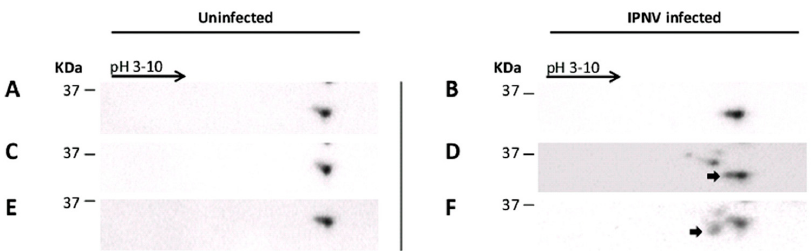
Figure 4. Effect of PKR inhibitor C16 on eIF2 α phosphorylation (CHSE-214 cells). Parallel wells